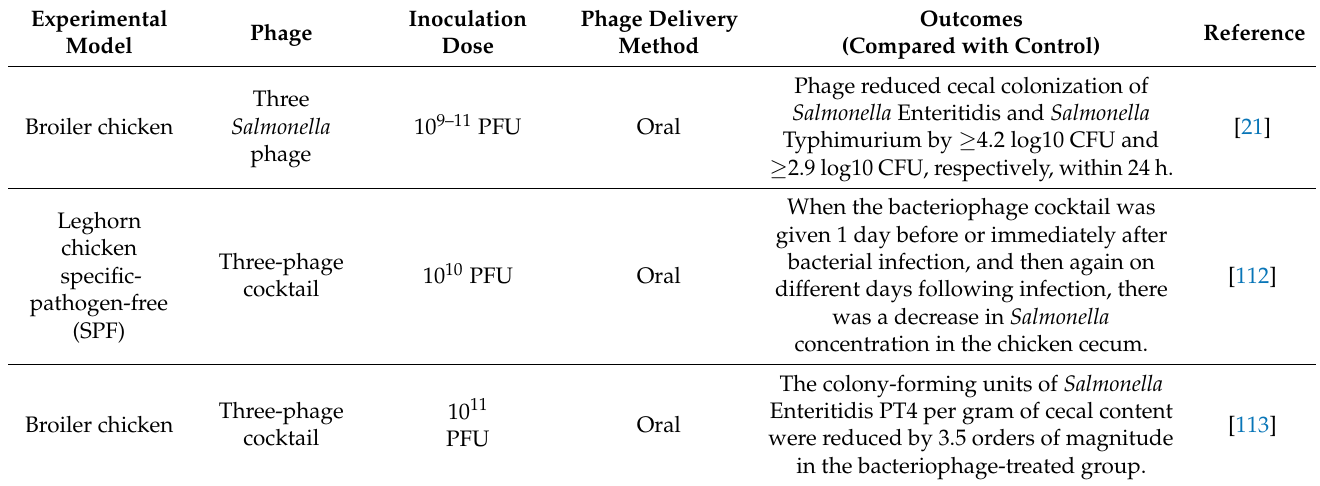
Table 3. Summary of the experimental studies on phage treatment to reduce colonization of Salmonella spp. in poultry and poultry